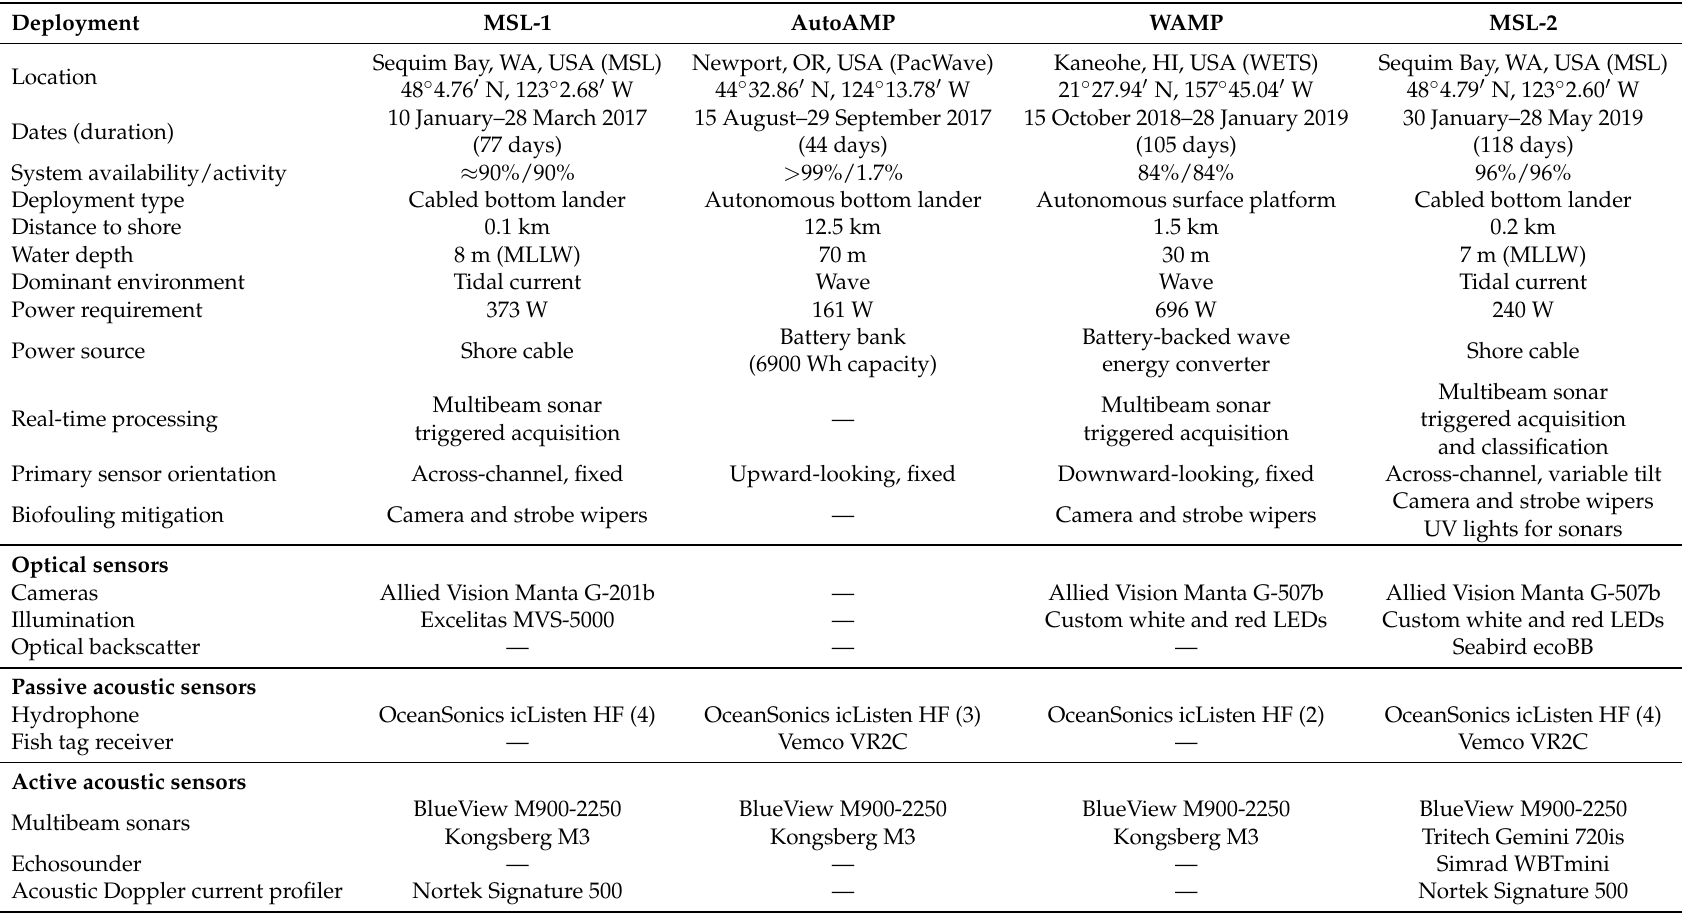
Table 2. Adaptable Monitoring Package deployment summary. “System availability” is % of time available for sensing and “system activity” is % of time actively sensing. Power requirements are only for offshore